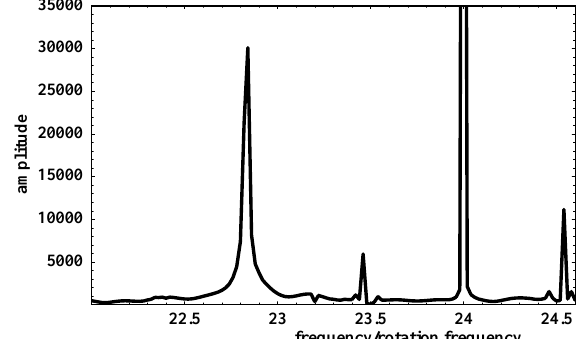
FIG. 2. Spectrum of the fourth order moments (cid:5) y 4 (cid:6) at 375 turns for (cid:1) n x , n y (cid:2) (cid:1) (cid:1) 5.82, 5.79 (cid:2) .